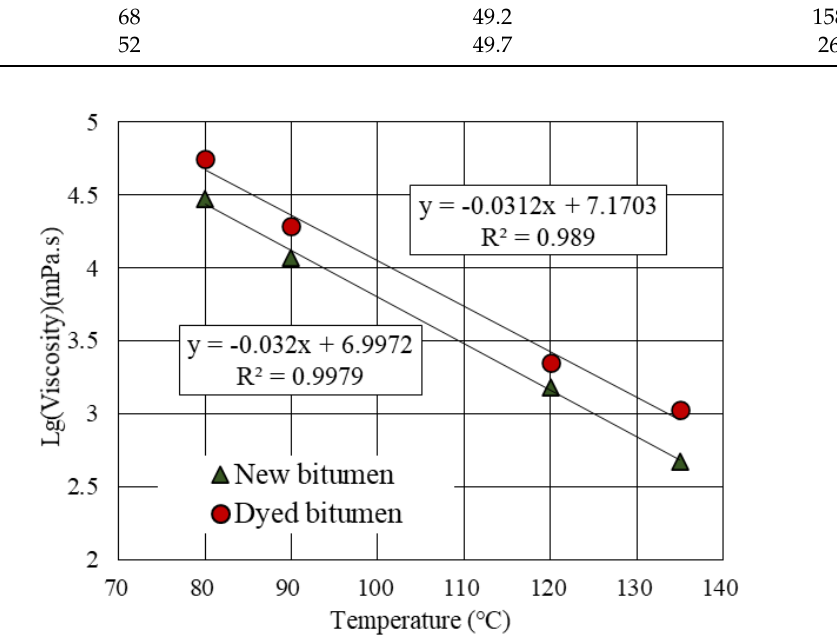
Table 1. Empirical parameters of PG70-22 bitumen and the dyed binder.